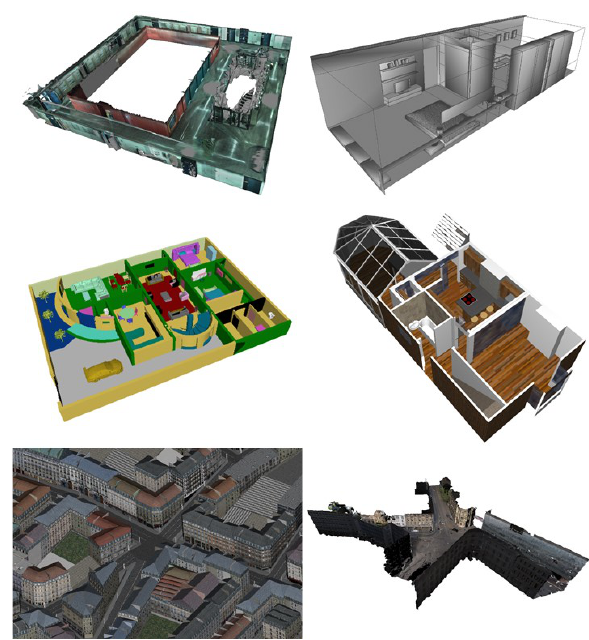
Figure 4. Indoor scenes (top row, middle row) and outdoor scenes (bottom row), top left and bottom right scenes are real scenes from dense matching/laser scanning The navigation in the scenes is not completely free, for every scene there are predefined locations to where the rig can be navigated (Figure 5). The predefined locations are marked with a blue sphere. The locations are predefined in order that the captured images and the resulted panoramas are reproducible and therefore comparable. Once selected a sphere, the position of the viewer and the rig will be changed. The UI allows to configure the rig and capture images on every location.